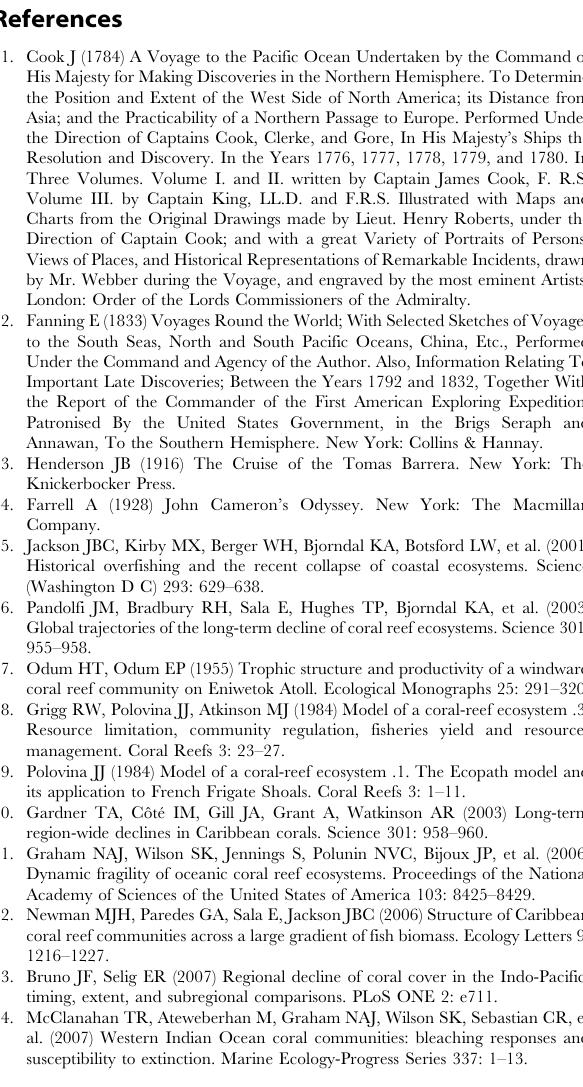
Table S3 Non-coral invertebrate abundance on the northern Line Islands.